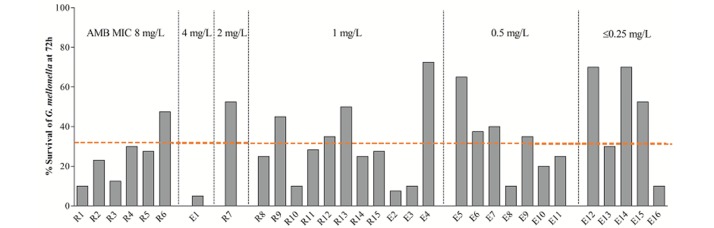
Survival rate (%) of Galleria mellonella larvae 72 h after inoculation with respiratory (R1 to R15) or ear (E1 to E16) A. terreus isolates.The 31 clinical A. terreus isolates exhibited marked diversity of virulence in G. mellonella model. Dotted horizontal bar indicates the mean value of the 31 isolates (32.6%). See Table 2 for detailed information on each isolate.